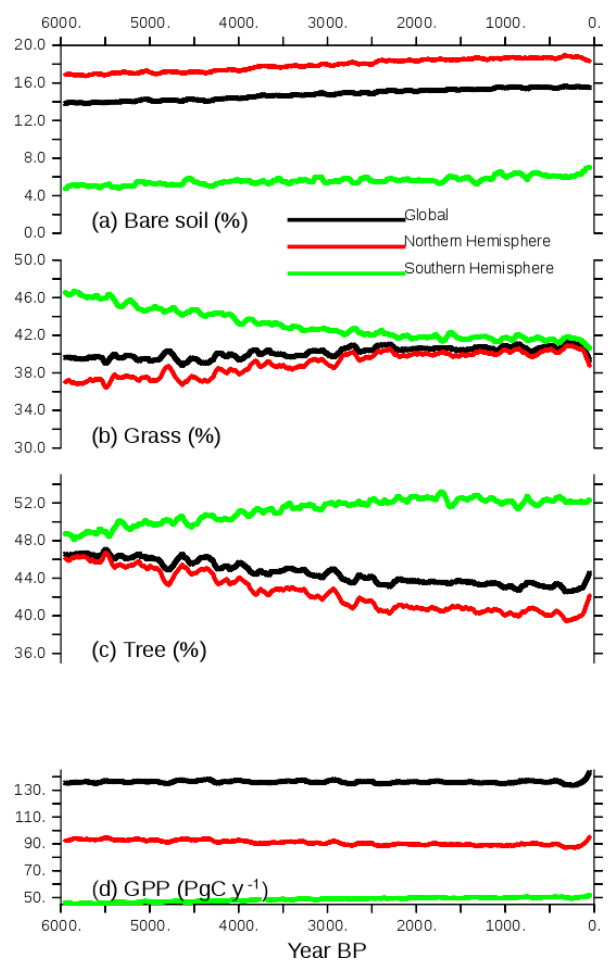
Figure 9. Long-term evolution of the simulated (a) bare soil, (b) grass, and (c) tree covers, expressed as the percentage (%) of global, NH, or SH continental areas, and (d) GPP (PgCyr − 1 ) over the same regions. Annual mean values are smoothed by a 100-year running